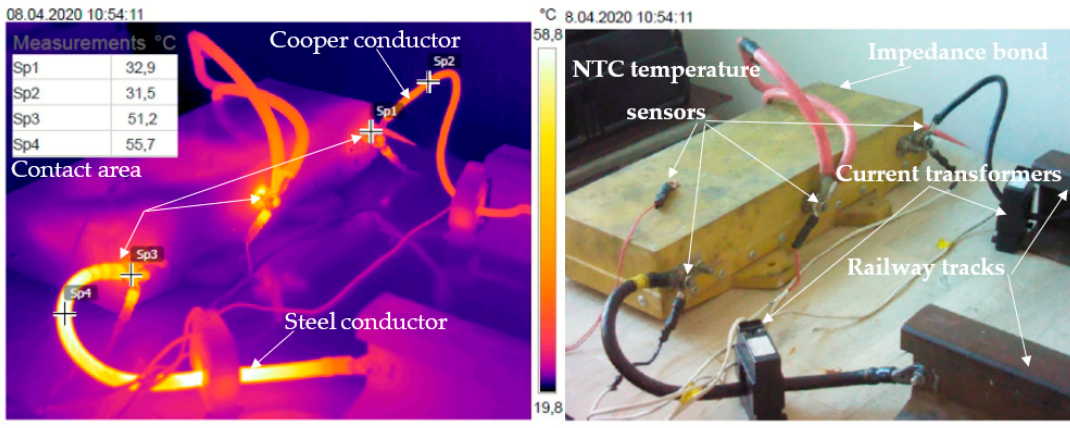
Figure 10. Thermographic image at a test current of 100 A.